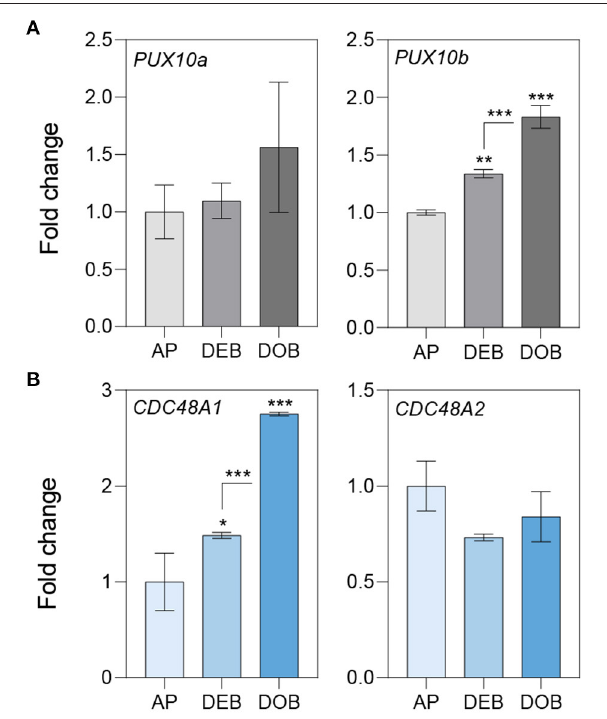
expression of genes encoding (A) UBX Domain-Containing Proteins (PUX10a, b) and (B) Cell Division Control Proteins (CDC48A1,2) in apices (APs) under long day and in developing buds (DEBs) and dormant buds (DOBs) in short days. Values are calculated relative to the control (AP) and represent the means of three technical replicates ± SD of four plants. Asterisk(s) indicate statistical significance between treatments (one-way ANOVA, Tukey analysis; * P < 0.05; ** P < 0.01; and *** P <